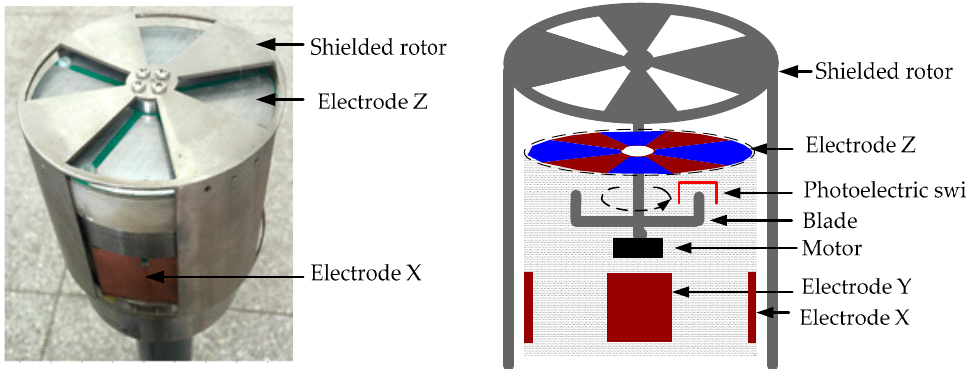
Figure 1. A photograph ( left ) and schematic ( right ) of the three-dimensional atmospheric electric field sensor.